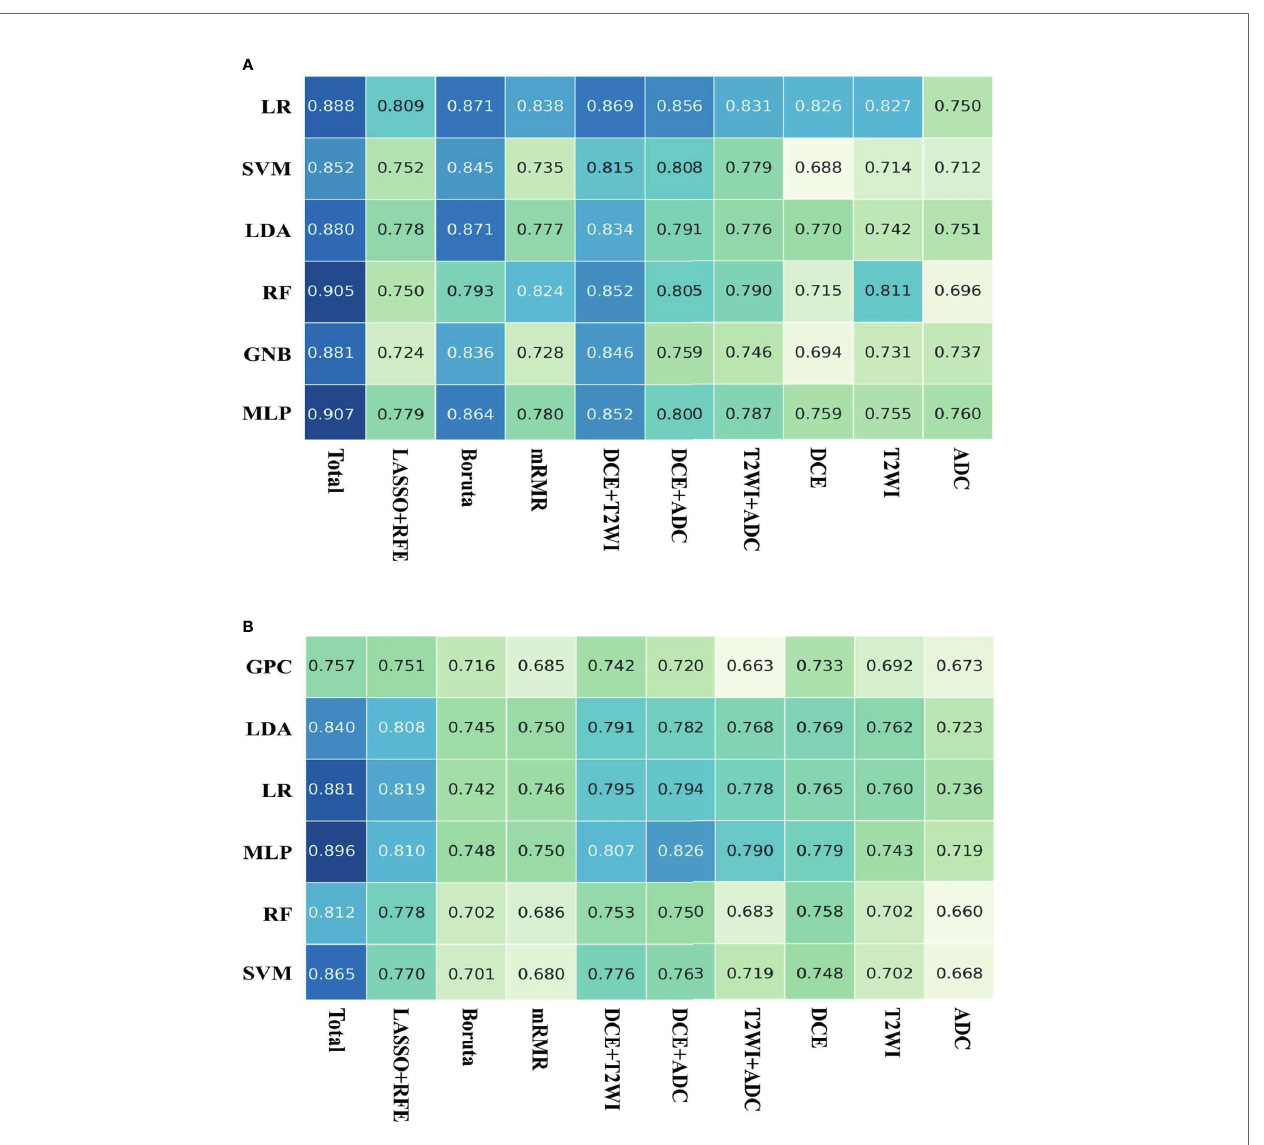
FIGURE 4 | AUCs of the models on the testing dataset. (A) Six machine learning classi fi ers and 10 feature sets were utilized for predictive model construction on predicting AR expression; (B) six machine learning classi fi ers and 10 feature sets were utilized for predictive model construction on predicting molecular subtype.